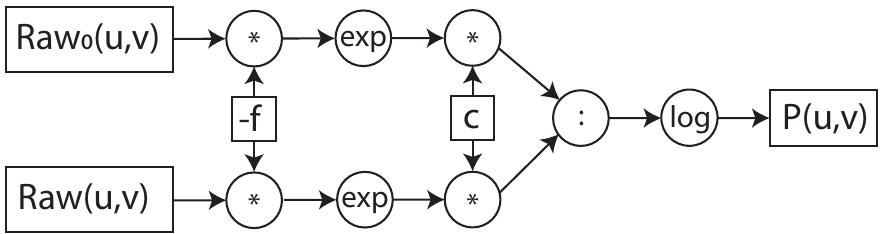
Figure 5. Data flow graph representation for the standard I0-correction.